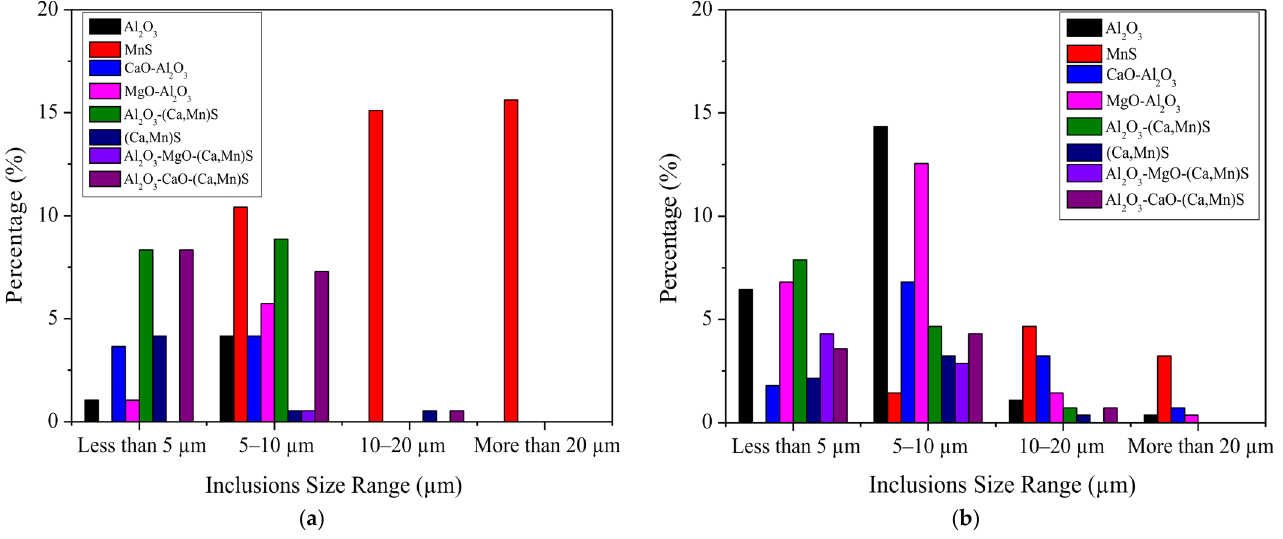
Figure 2. The size of different types of inclusions in the gear steels. ( a ) GS1 sample, ( b ) GS2 sample.